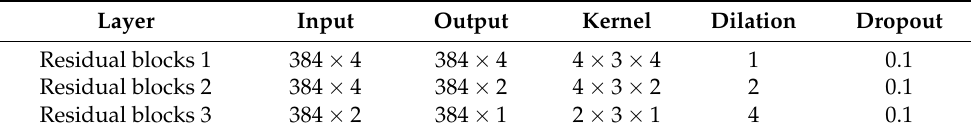
Table 7. Layer architecture of the temporal convolutional network.